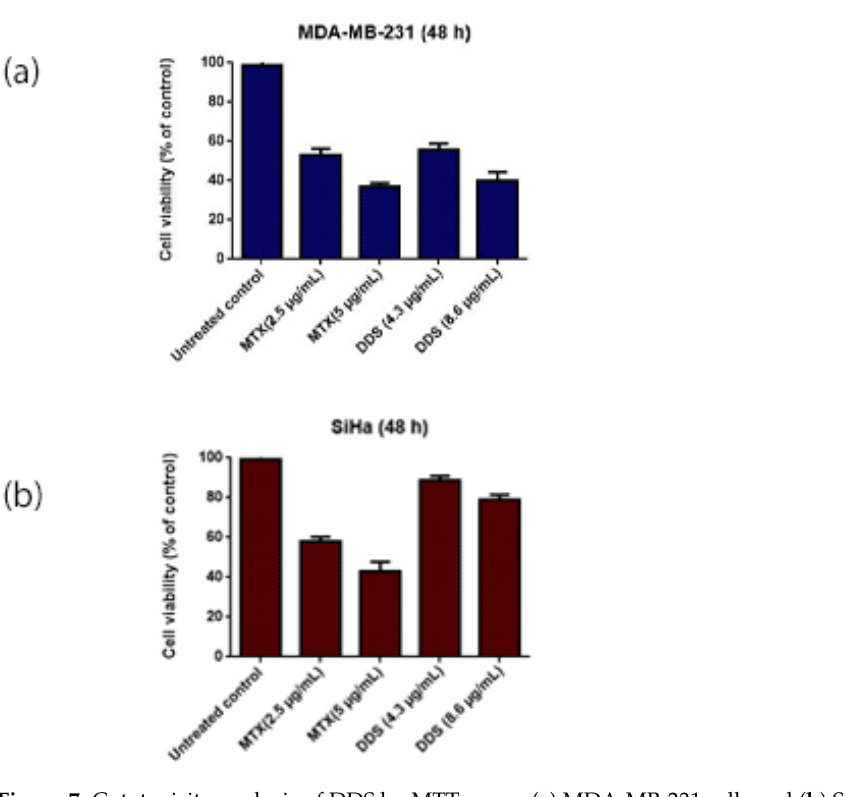
Figure 7. Cytotoxicity analysis of DDS by MTT assay: ( a ) MDA-MB-231 cells and ( b ) SiHa cells. The experiment was conducted in triplicate, and the data are represented as the arithmetic mean ± SD.